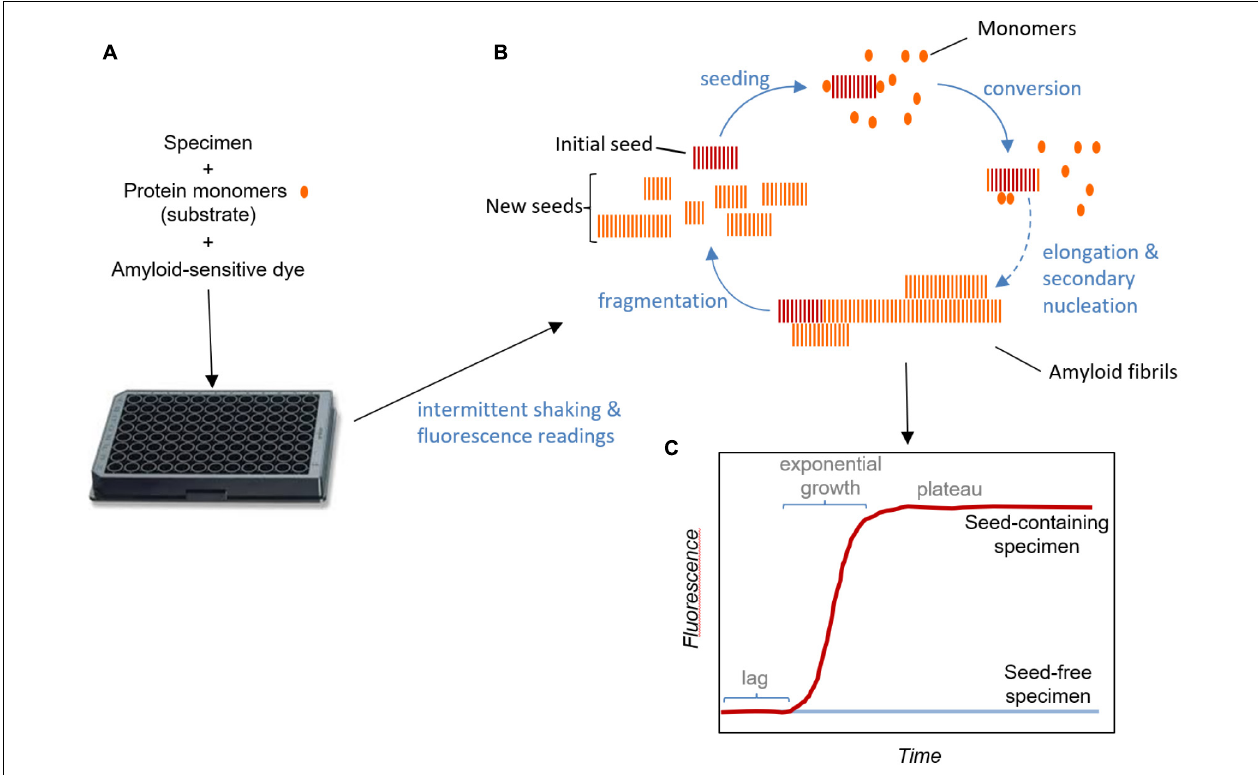
FIGURE 1 | Real-time quaking- induced conversion assay schematic. (A) Test specimens are added to multi-well plates along with solutions of substrate protein monomers and an amyloid sensitive dye such as thioflavin T. The plates are subjected to intermittent shaking and fluorescence readings in a temperature-controlled plate-reader. (B) Amplification cycle: Seeds in the specimen bind monomers and induce their conformational conversion as they are recruited into the growing fibril. Secondary nucleation may occur due to assembly and conversion of monomers on the sides of fibrils, contributing, along with fragmentation, to the generation of new seeding surfaces. New seeding surfaces are critical in obtaining exponential growth kinetics. (C) Fluorescence readout: Binding of the dye to amyloid fibrils enhances its fluorescence. In the absence of pre-existing seeds in the specimen, amyloid fibril formation requires spontaneous nucleation, which, under conditions optimized for these assays at least, is much slower than the growth and fragmentation of pre-existing seeds. In reactions provided with pre-existing seeds, the lag corresponds to the phase in which seeds are growing at sub-detectable levels. The fluorescence plateaus once the available monomer is consumed. Sometimes fluorescence can even decrease after peaking, an effect that is likely due to consolidation or redistribution of fibrils in the well in a way that affects the fluorescence measurement (not